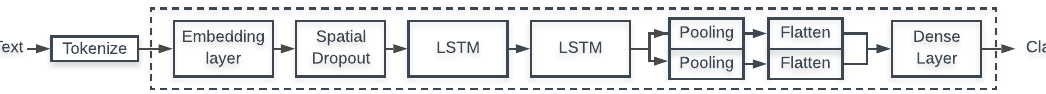
Figure 3. A Deep Neural Network with Tf-Idf Embeddings.